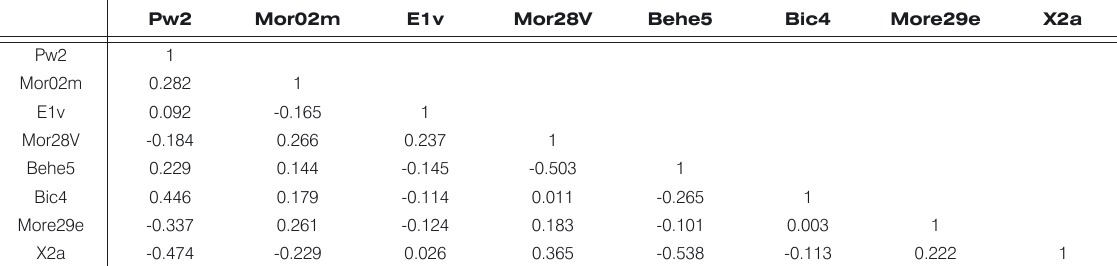
Table 3. Correlation matrix for the eight selected